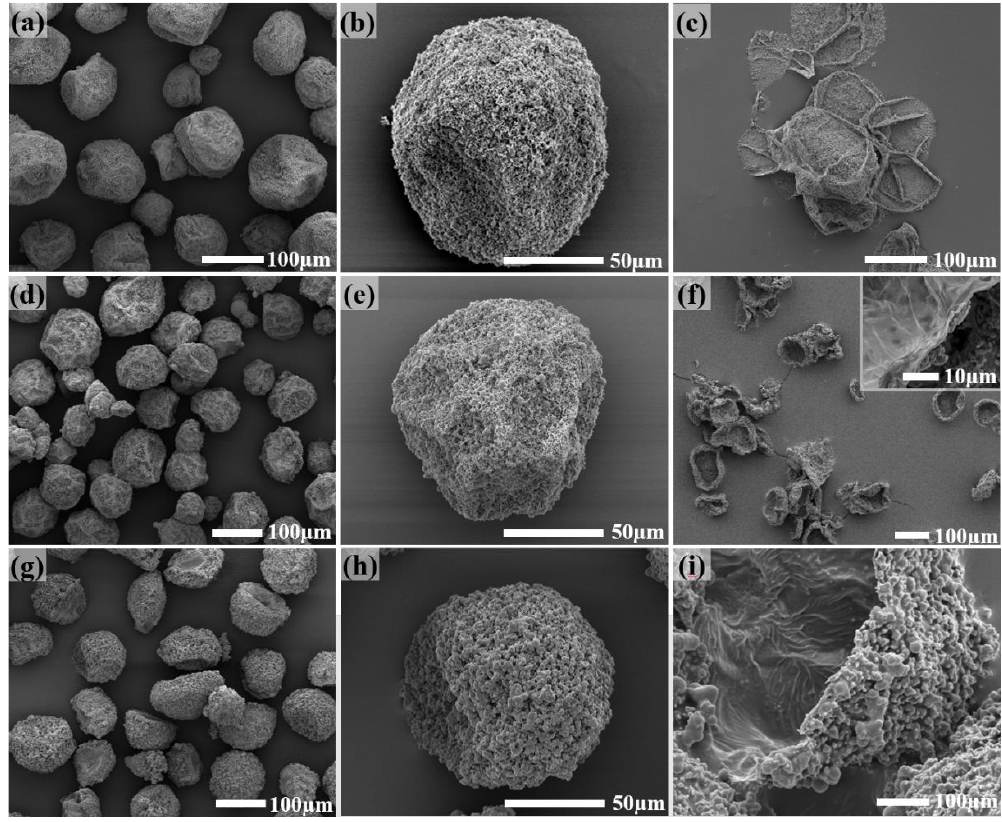
Figure 8. SEM images of the microcapsules were obtained at different reaction conditions. ( a – c ) 5 h at 50 °C, ( d – f ) 40 °C for 1 h, 50 °C for 2 h, and 60 °C for 2 h in order, and ( g – i ) 60 °C for 5 h using T50-5h.